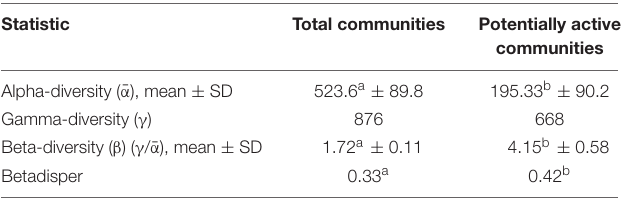
TABLE 1 | Diversity metrics for the potentially active (RNA) and total (DNA) hypolith